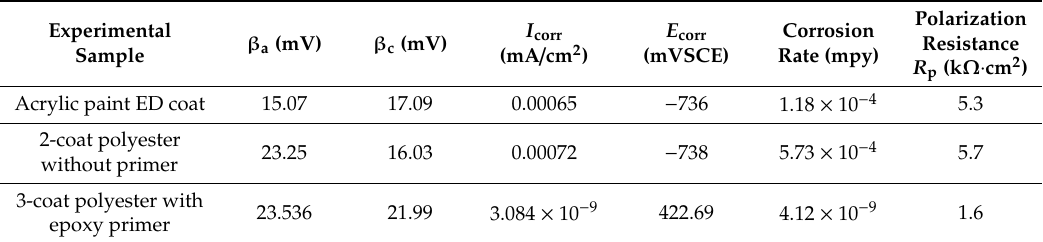
Table 2. Polarization